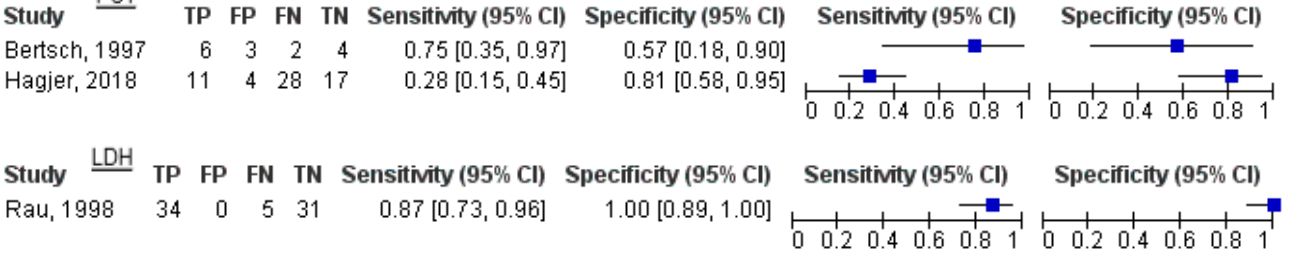
Figure 3. Forest plots of PCT and LDH showcasing the sensitivity and specificity of the tests. The cutoff for PCT was >0.5 ng/mL for both studies. The threshold for LDH was >290 U/L. The summary receiver operating characteristic (SROC) plot showcases that LDH (day